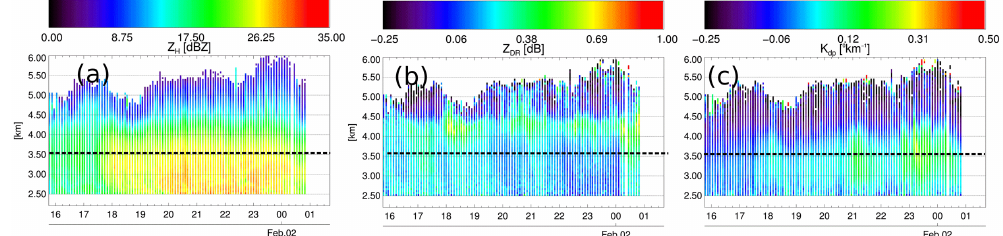
Figure 13. As in panels (a) or (b) of Fig. 12 but showing (a) Z H (dBZ), (b) Z DR (dB), and (c) K dp ( ◦ km − 1 ). Note that panels (a) and (b) of Fig. 12 display data collected at vertical incidence, while in this image the data are mean-per-height values of RHI images.